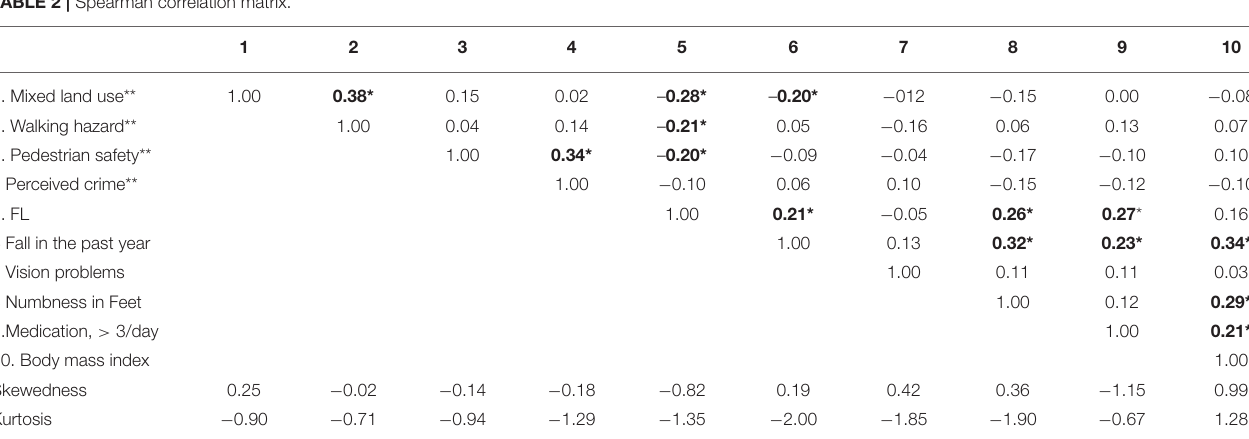
TABLE 2 | Spearman correlation matrix.